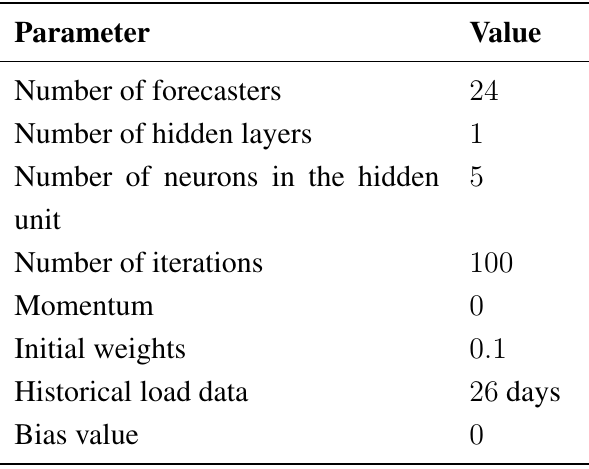
Table 1. Simulation